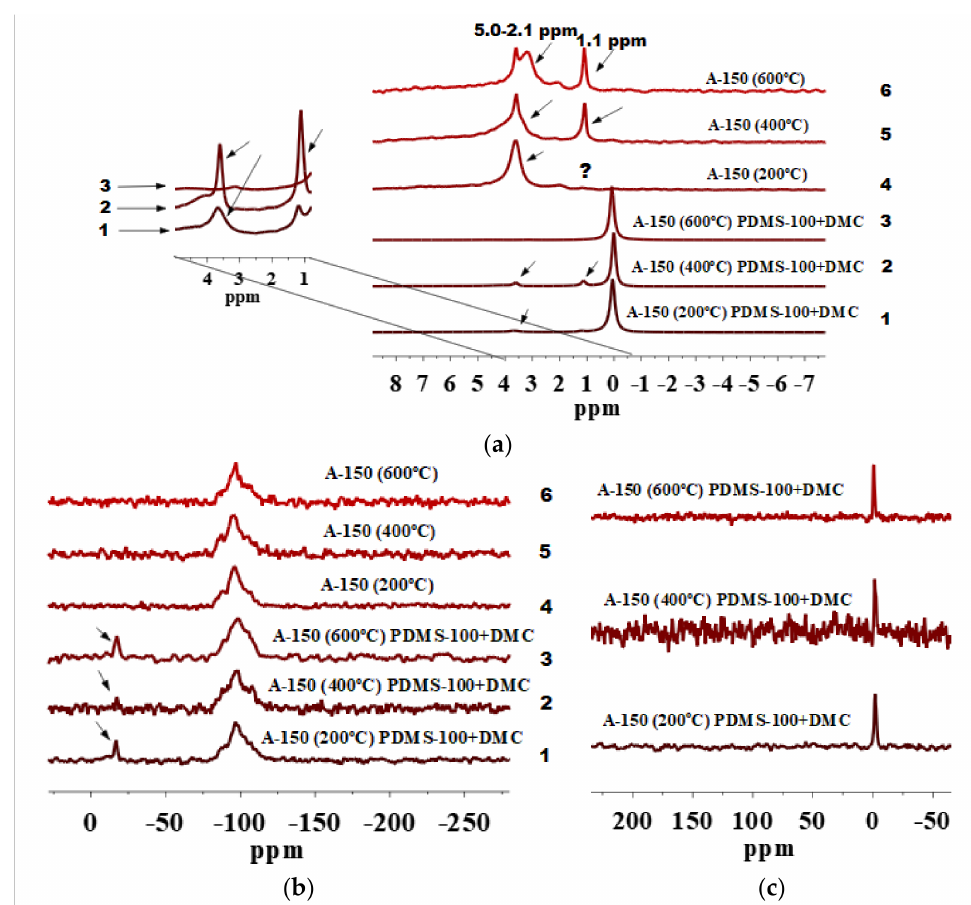
Figure 3. ( a ) 1 H MAS NMR, ( b ) 29 Si CP/MAS NMR and ( c ) 13 C CP/MAS NMR spectra of fumed silica A-150 preheated at 200, 400 and 600 ◦ C and modified by